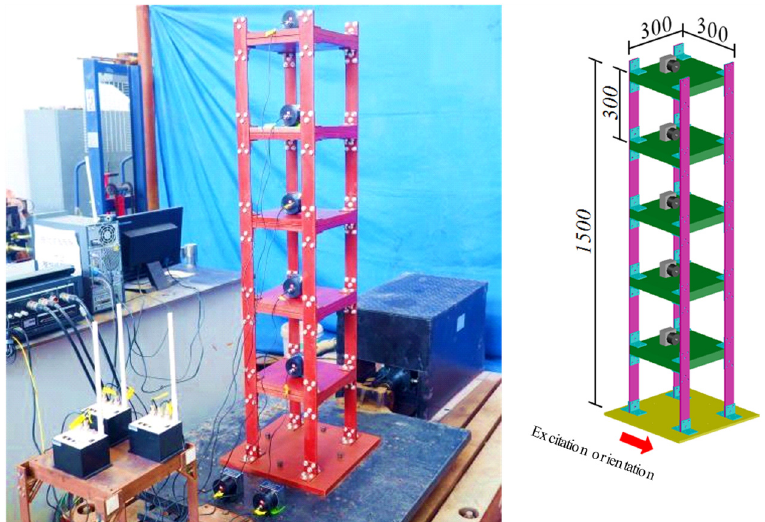
Figure 9. Frame and sensor configuration of the shake table test.